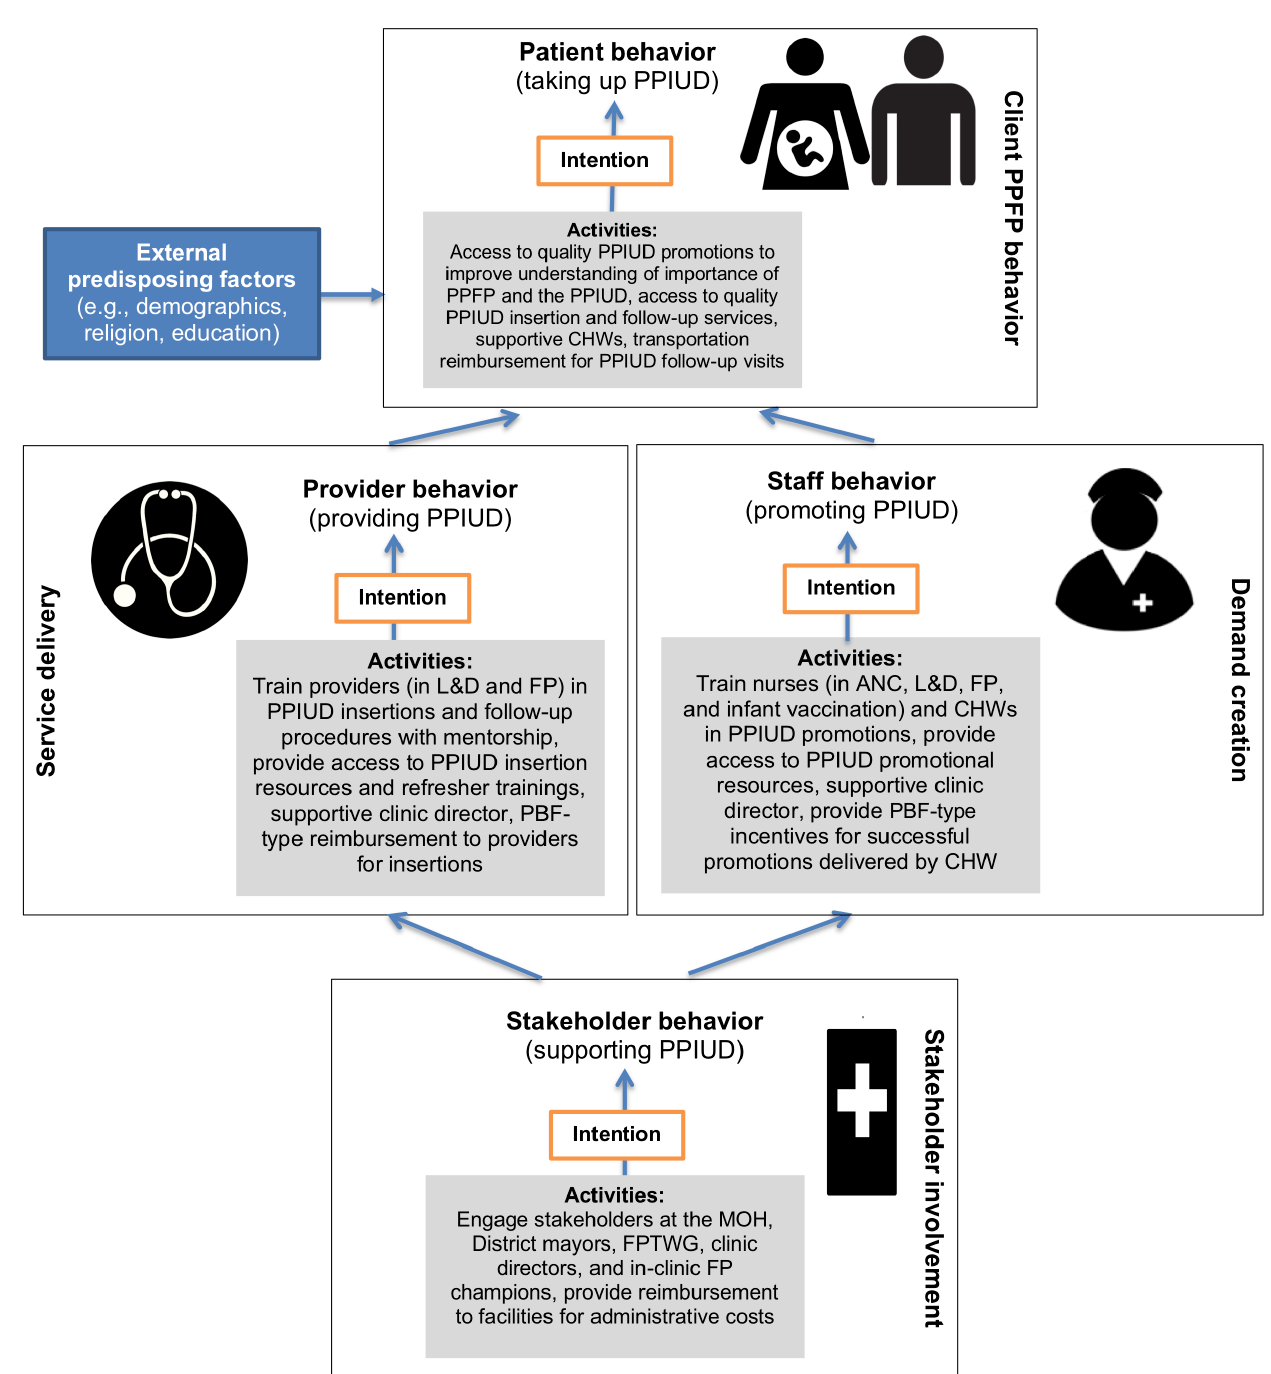
Figure 1. Framework of the PPIUD intervention at multiple levels of the healthcare system. Grey boxes indicate intervention activities designed to change attitudes, norms, and perceived control. PPIUD: postpartum intrauterine device; PPFP: postpartum family planning; FPTWG: Family Planning Technical Working Group; ANC: antenatal care; L&D: labor and delivery; FP: family planning; CHW: community health worker; PBF: performance-based financing; MOH: Ministry of Health.